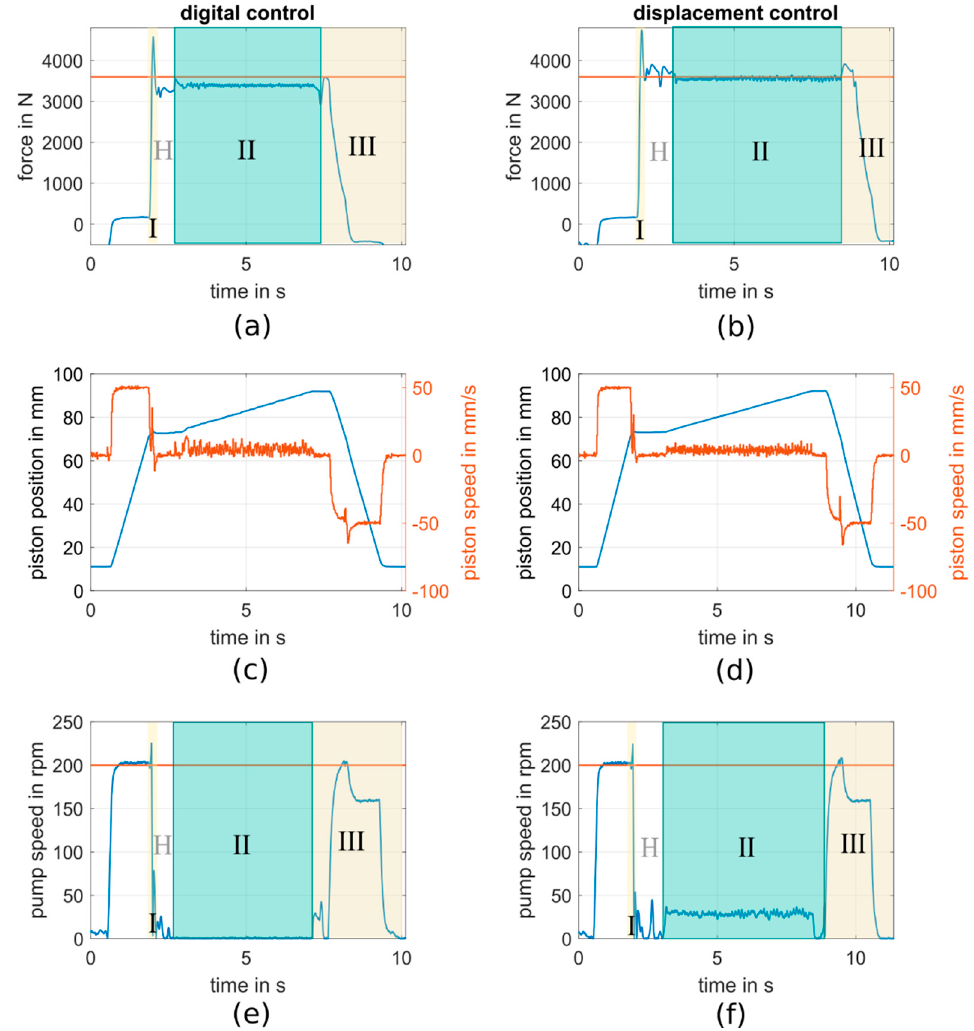
Figure 5. Measured force curves ( a , b ), the corresponding piston position and piston velocity ( c , d ), as well as the absolute pump speed ( e , f ) for digital control and displacement control respectively.